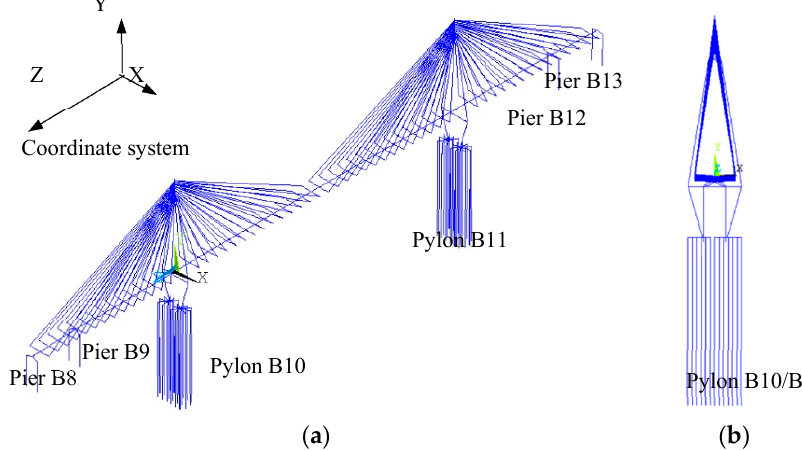
Figure 11. FE model using a fish-bone structural system. ( a ) Axonometric view, ( b ) Vertical view.